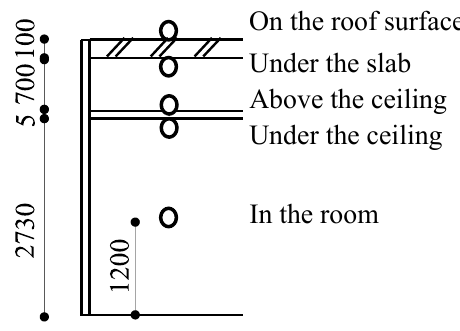
Figure 2. Cross section of temperature measurement